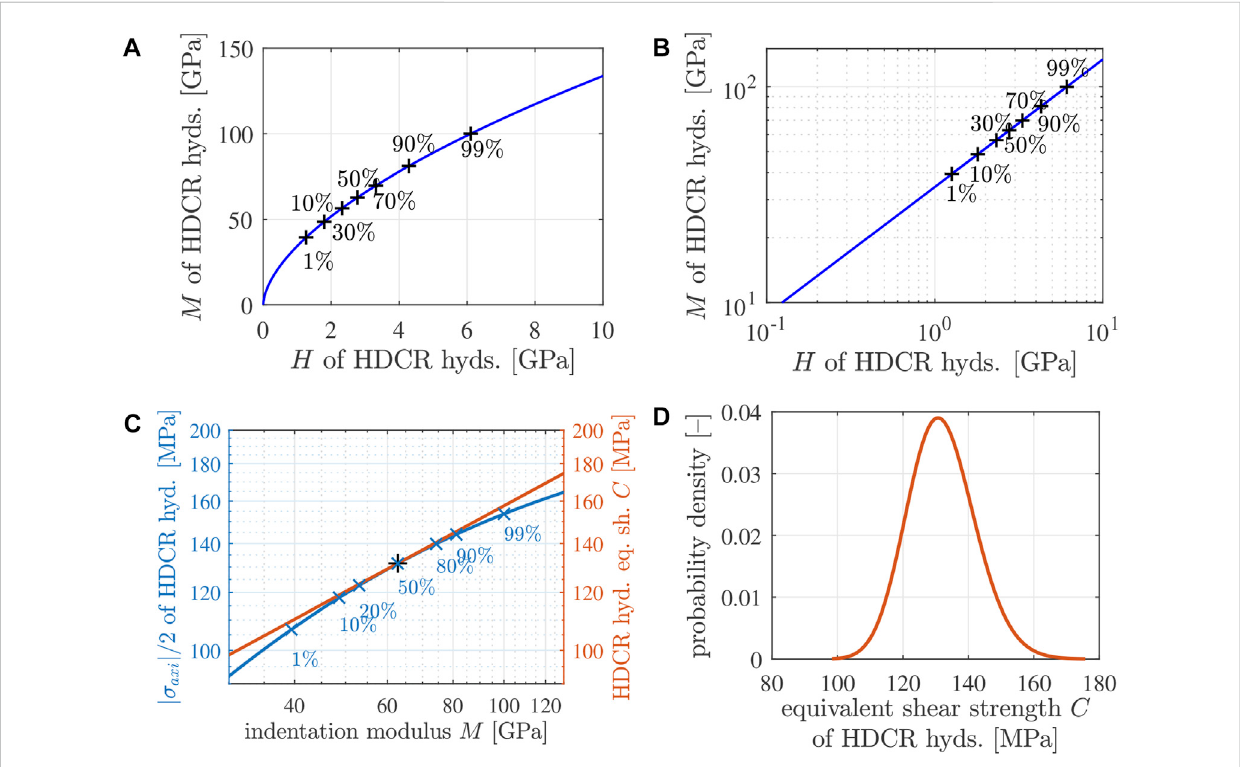
FIGURE 12 (A, B) Quantile-based correlation between the lognormal distributions of the indentation modulus M and the indentation hardness H of the HDCR hydrates: representation of the power-law-relation according to Eq. 37 with X = H , Y = M , μ M = 4.14, σ M = 0.20, μ H = 1.02, and σ H =0.34, see Table 8 and (Dohnalík et al., 2021): (A) natural scale, (B) double-logarithmic representation; the black “ + ” symbols mark p -quantiles, with values of p equal to the printed percentage values. (C) Illustration of the failure criterion of Eq. 34: the equivalent shear strength of all HDCR hydrates (orange line) is larger than | σ axi /2| (blue line), except for the median value of the indentation modulus, for which | σ axi /2| = C ; the blue “ + ” symbols mark p -quantiles, with values of p given as percentage values. (D) Lognormal probability density distribution of the equivalent shear strength of the HDCR hydrates explaining macroscopic failure of mature Biodentine under uniaxial compression according to Eq. 30; the lognormal parameters are given in Eqs 39,